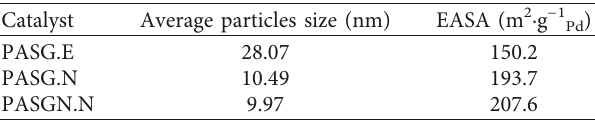
Table 3: EASA result of